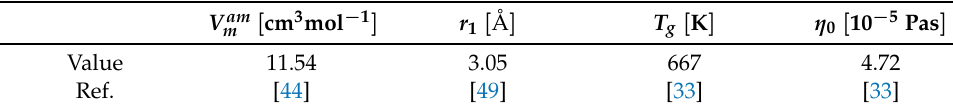
Table 1. The material parameters used in the